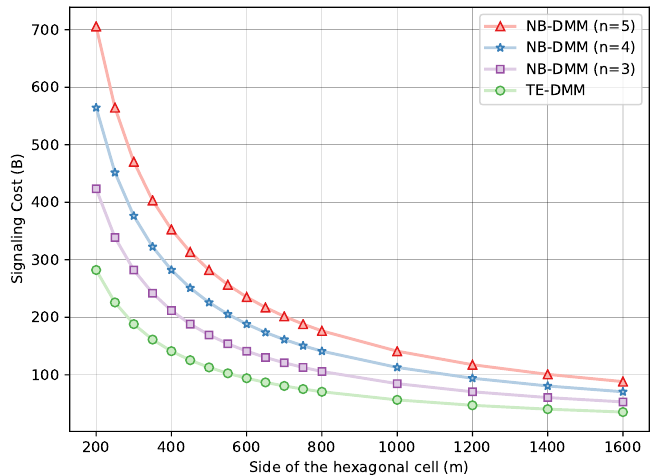
Figure 7. Signaling cost depending on side of the hexagonal